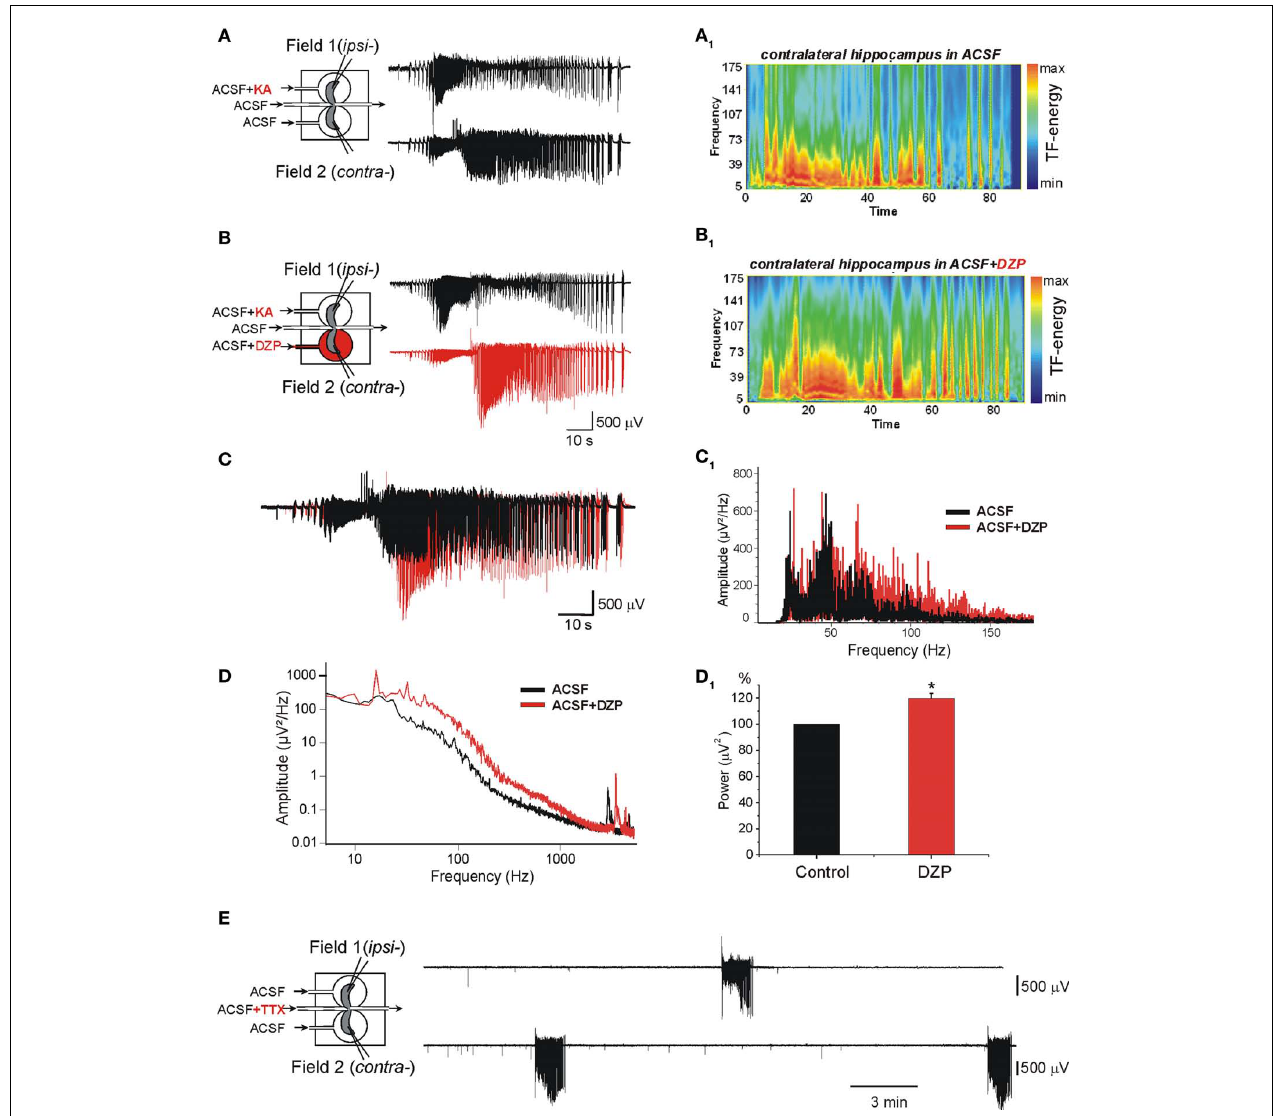
FIGURE 1 | Diazepam (DZP) aggravates the propagating ictal-like events (ILEs) and does not prevent the formation of a mirror focus by repeated ILEs. (A,B) The scheme of the triple chamber preparation with the two intact hippocampi and their connecting inter-hemispheric commissure in independent chambers ( left ). Field recordings were made in the two hippocampi. (A) Kainate (KA) applied to one hippocampus (ipsilateral: ipsi- ) generated seizure activity referred to as ILE that propagated to the contralateral hippocampus ( contra- ) . The ILEs included high frequency gamma oscillations (GOs, 40–120Hz) as shown in the time–frequency (TF) analysis (A 1 ) . (B) Application of DZP to contralateral hippocampus (2 μ M, 15min) before a second application of KA increased the ILE and GOs.TF analysis of ILE recorded in contra- is shown in (B 1 ) . (C) Superimposed ILEs [from (A,B) ]